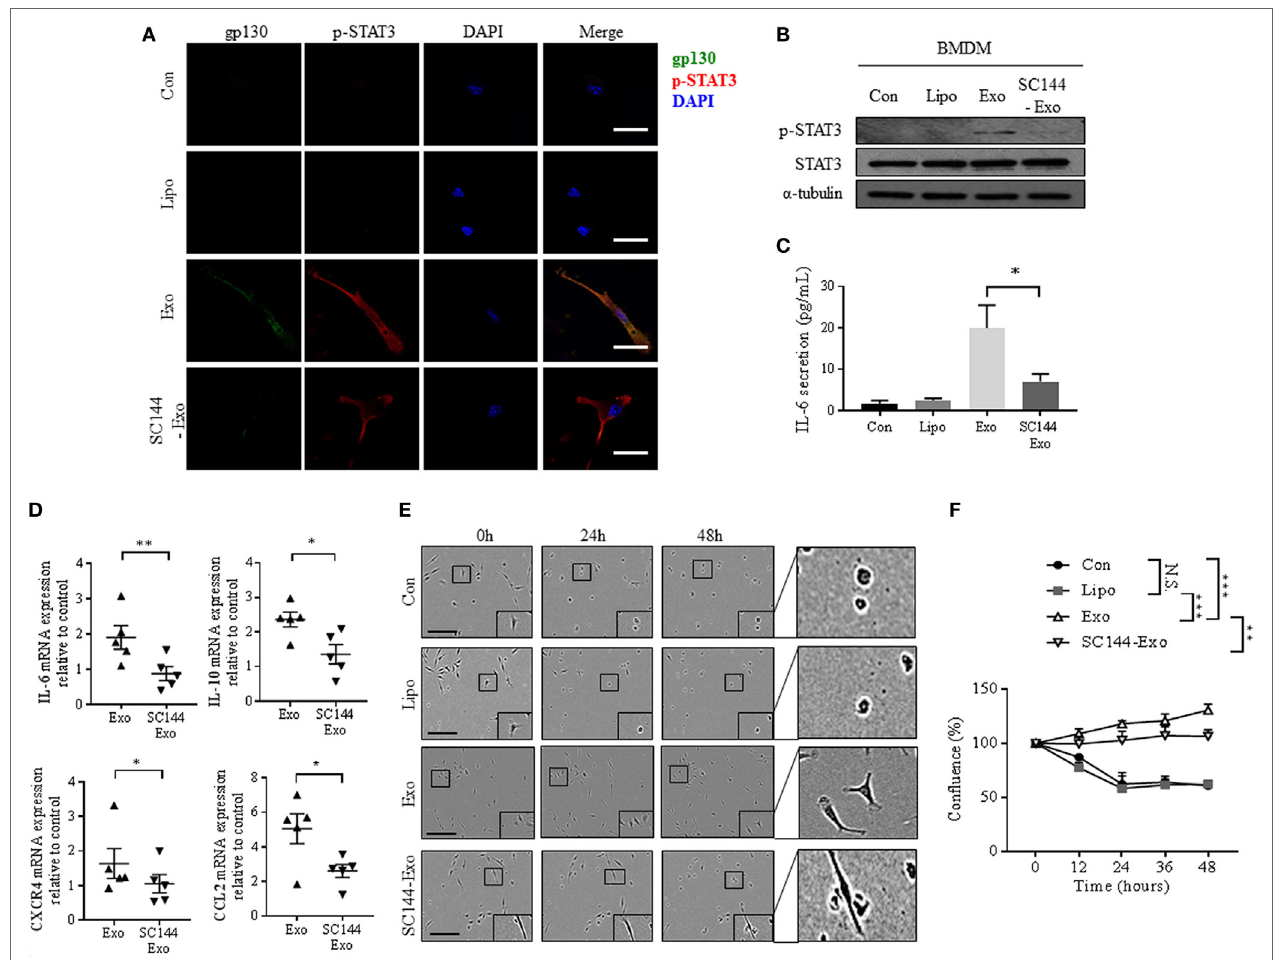
FigUre 4 | Inhibition of exosomal gp130 by SC144 reduces the breast cancer exosome-mediated phenotypical changes in bone marrow-derived macrophages (BMDMs). (a) gp130 and p-STAT3 expression were assessed after exposure of macrophages to PBS, liposomes, exosomes, or SC144 pretreated exosomes for 24 h by immunofluorescence microscopy. The images were captured at 100 × magnification, and the size bar represents 20 µm. Nuclei of macrophages were visualized with DAPI. (B) The protein expression levels of p-STAT3 and STAT3 was assessed in macrophages cell lysates after the indicated 24-h treatments. α -Tubulin served as loading control. (c) Interleukin-6 (IL-6) secretion by macrophages after the indicated 24-h treatments was assessed by ELISA ( n = 6). * p < 0.05 as indicated. (D) IL-6, IL-10, CXCR4, and CCL2 gene expression was quantified by qRT-PCR in macrophages after 24-h exposure to exosomes or SC144 pretreated exosomes as indicated. Relative gene expression levels were normalized to GAPDH and results are shown as relative to PBS control ( n = 5). * p < 0.05; ** p < 0.01. (e) Incucyte images of macrophages after indicated treatments for 0, 24, and 48 h. The size bar represents 20 µm. (F) Quantitative representation of Incucyte results. Cell confluence was quantified at 5 time points, as an average of 16 images captured per time point. Data were normalized to cell count at 0 h ( n = 4 independent experiments). ** p < 0.01; *** p < 0.001; N.S., not statistically significant, as